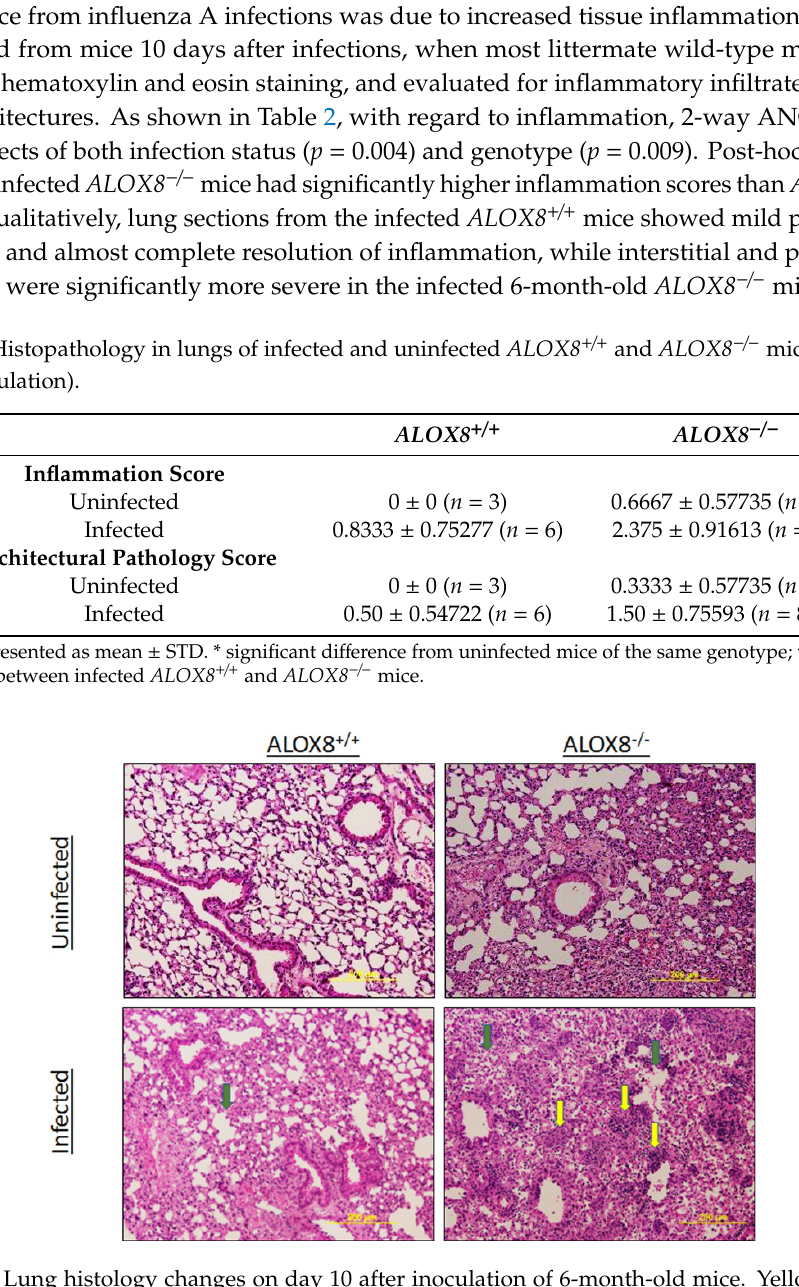
Figure 4. Lung histology changes on day 10 after inoculation of 6-month-old mice. Yellow arrows indicated the inflammation and the green arrows indicated the alveolar pathology changes.